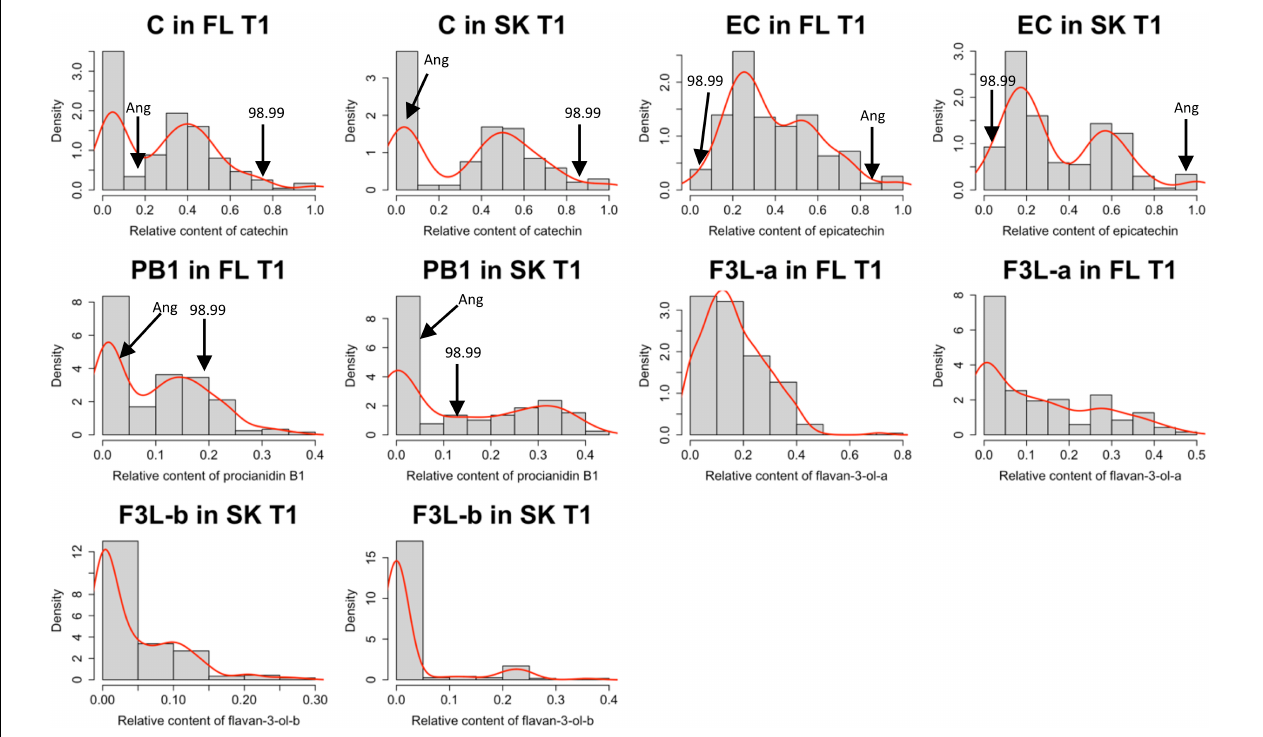
FIGURE 2 | Data distribution of each flavan-3-ol was identified in the Japanese plum fruits. Each histogram shows the distribution of the relative content of each flavan-3-ol, relative to the total amount of flavan-3-ol observed. Flavan-3-ol contents were measured by the HPLC-DAD method in the flesh (FL) and skin (SK) of the Japanese plum fruits. The distribution of the relative contents is shown only in one season (T1). The mean values of the parents (‘98–99’ and ‘Angeleno’) for each trait are indicated with a black arrow. C, catechin; EC, epicatechin; PB1, proanthocyanidin B1; FL3-a and F3L-b, two flavan-3-ol dimers denoted as “a” and